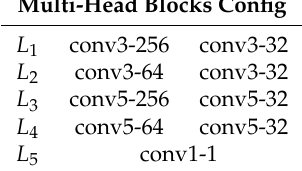
Table 1. Configuration of the Multi-Head layers of the proposed MH-MetroNet architecture (Figure 1). Each block is composed of two convolutional layers except for L 5 (only one conv layer) and their parameters are denoted as conv-(kernel size)-(number of